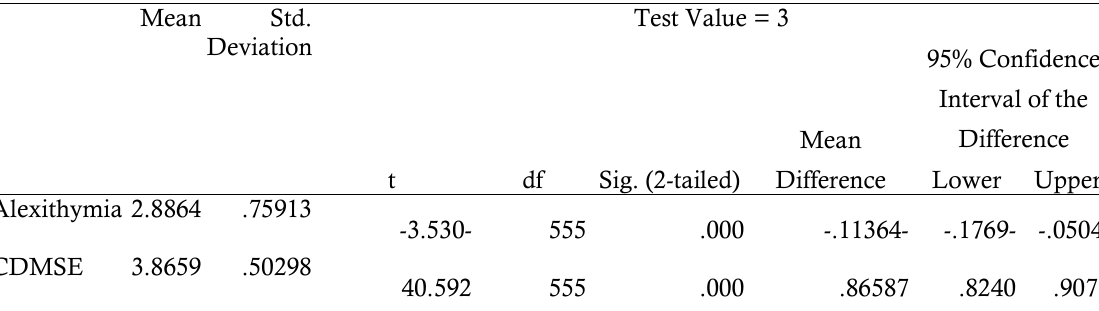
Table 3. Findings of t-test of One-